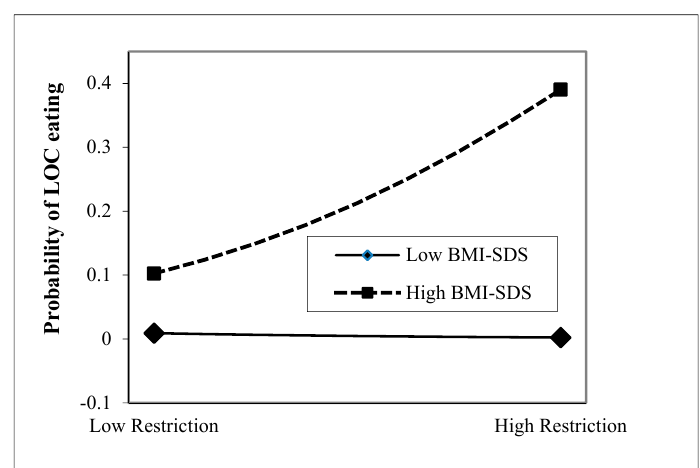
Figure 2. Interaction effect of children’s body mass index-standard deviation score (BMI-SDS) and